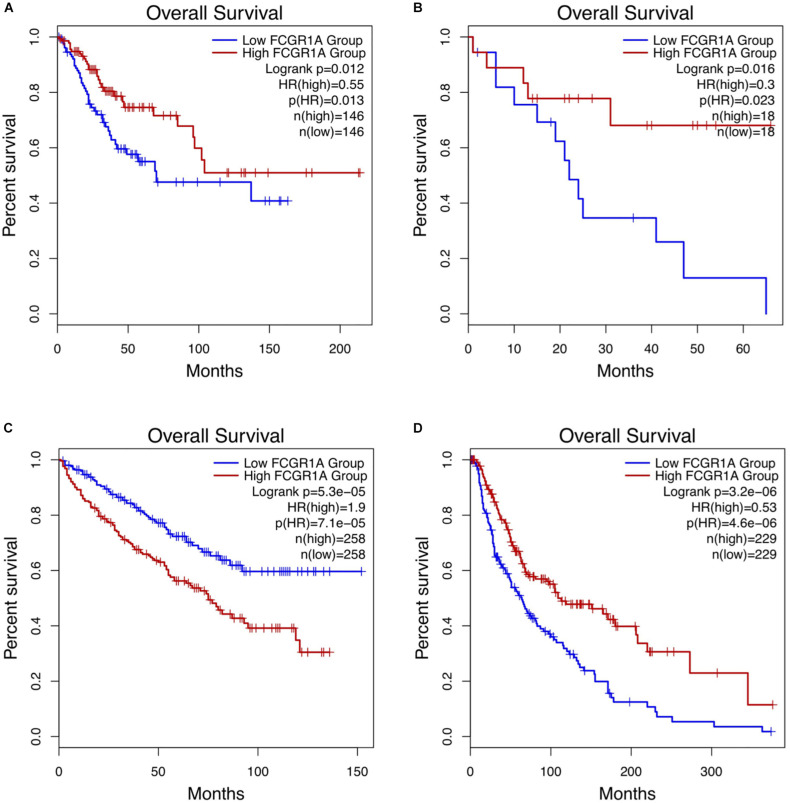
Kaplan–Meier survival curves comparing the high and low expression of FCGR1A in four cancer types in GEPIA. (A) CESC, (B) CHOL, (C) KIRC, and (D) SKCM.